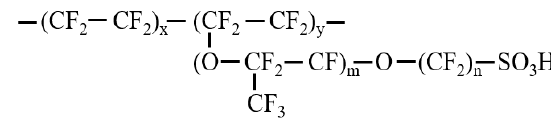
Figure 3. Chemical structure of the ionomer monomer. Table 1. Molecule numbers in models with different water contents.